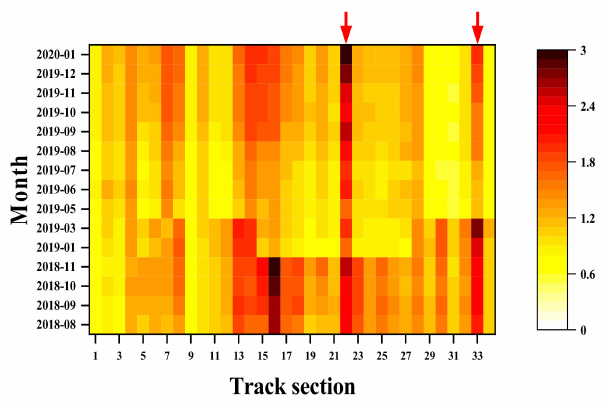
Figure 3. Memory effect of track